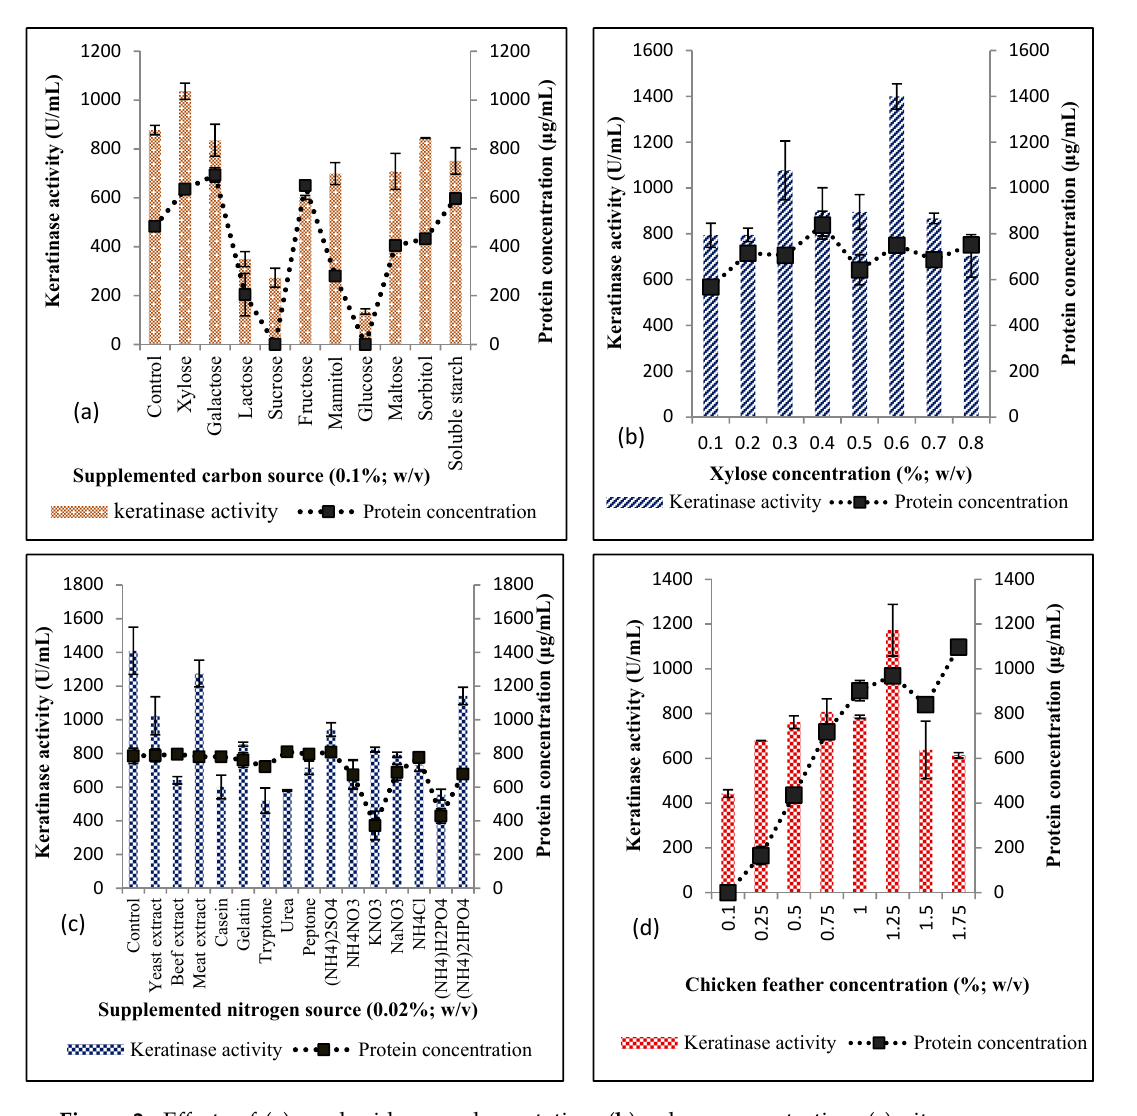
Figure 2. Effects of ( a ) saccharides supplementation, ( b ) xylose concentration, ( c ) nitrogen source supplementation, and ( d ) chicken feather concentration on keratinase production by Bacillus sp. Nnolim-K1. Each point represents the mean and standard deviation of triplicate experiments.